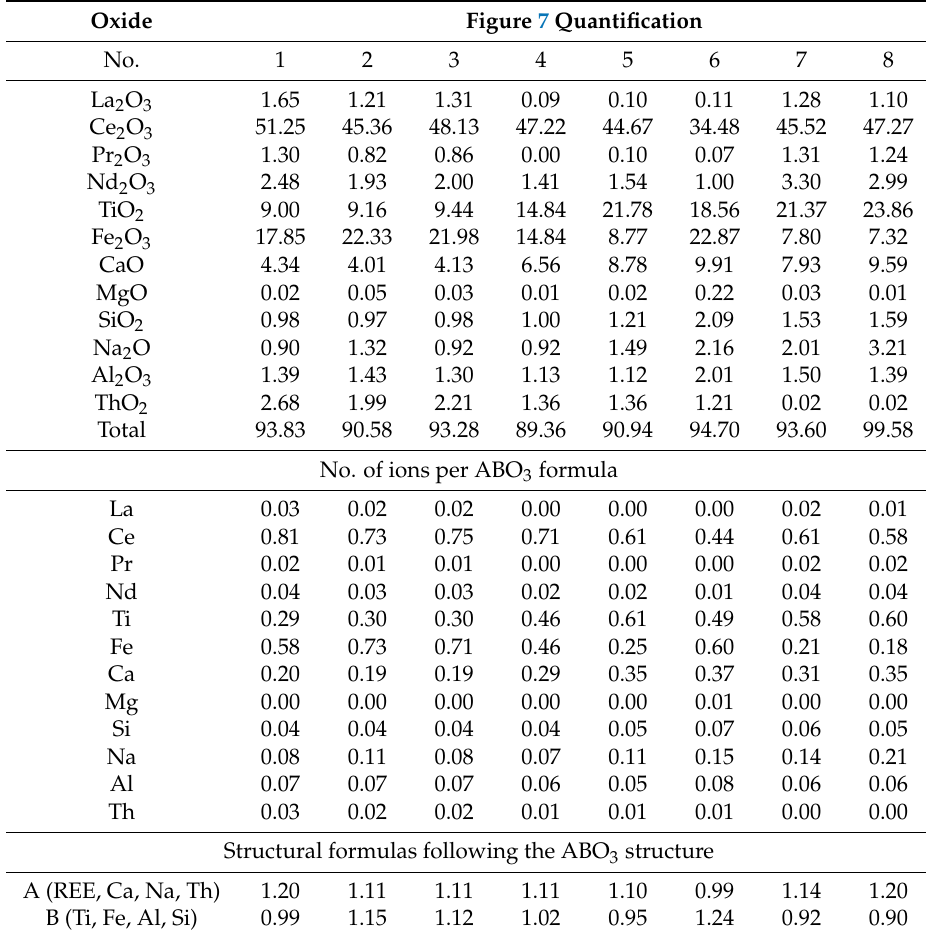
Figure 7. Backscattered electron images of cerium ferrotitanate grains in bauxite residue matrix ( a – c ). The indicated quantification spots are reported in Table 5. Table 5. EPMA-WDS quantification (wt %) of cerium predominant ferrotitanate grains (Figure 7). Lower section of the table shows the number of ions in the mineral formula, following the ABO 3 perovskite structure.